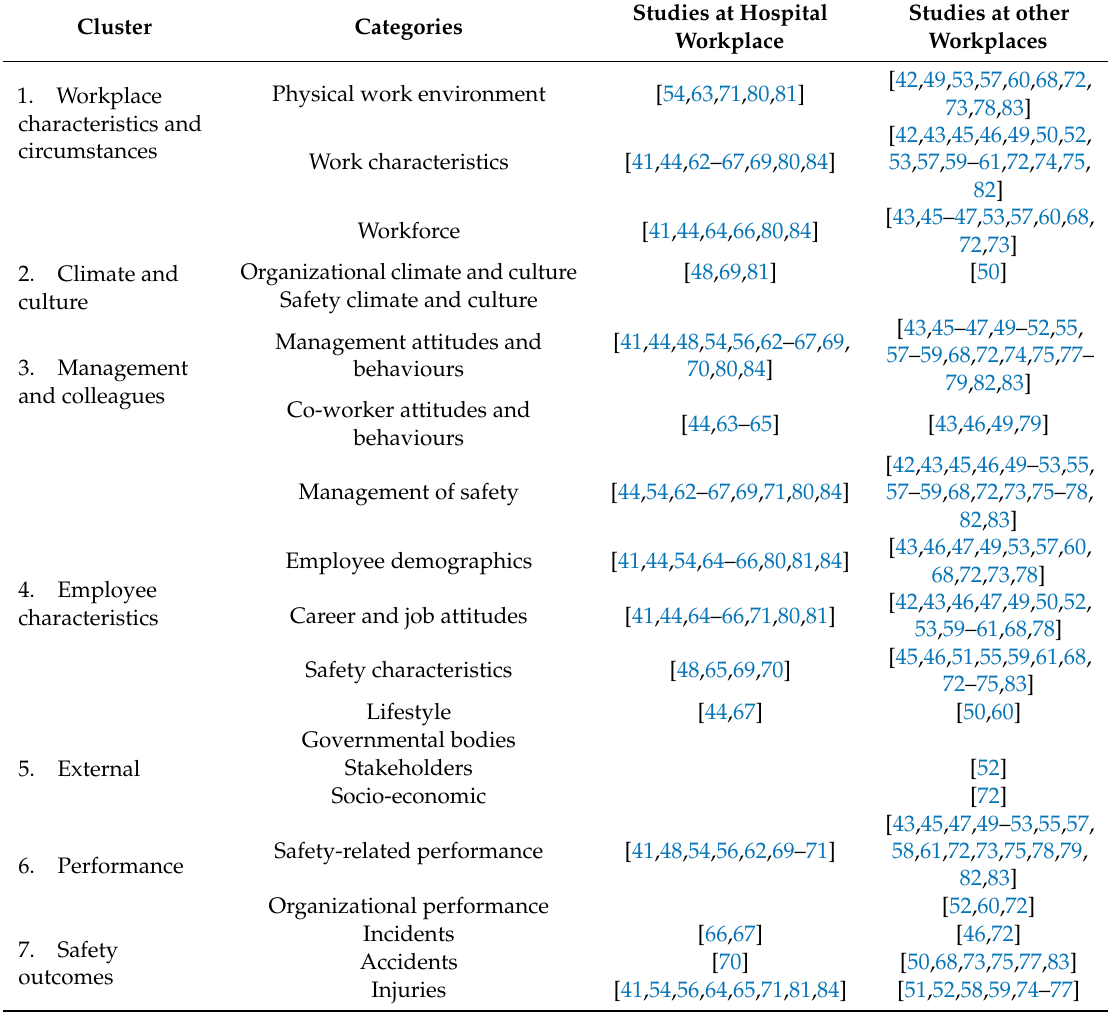
Table 4. Summary and classification of the studies addressing cluster, topics, and categories according to Cornelissen et al.